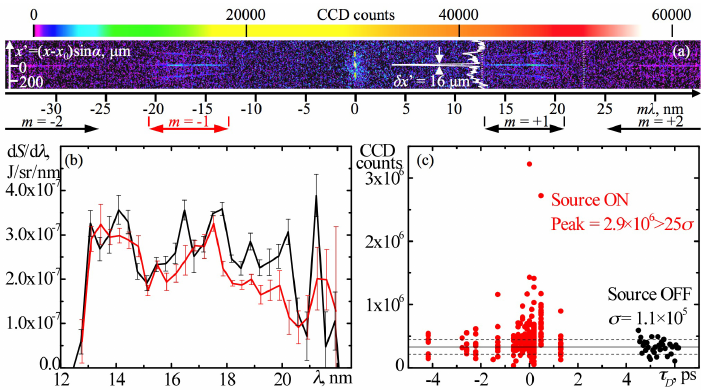
Figure 5. Reflected signals reproduced from [37]. ( a ) Raw charge-coupled device (CCD) image after the transmission grating. ( b ) Spectra with the diffraction orders of +1 and − 1. ( c ) CCD counts within the 1st diffraction order vs. time delay between the driver and source pulses; also shown are results of the shots without the source pulse the delays of which are assinged